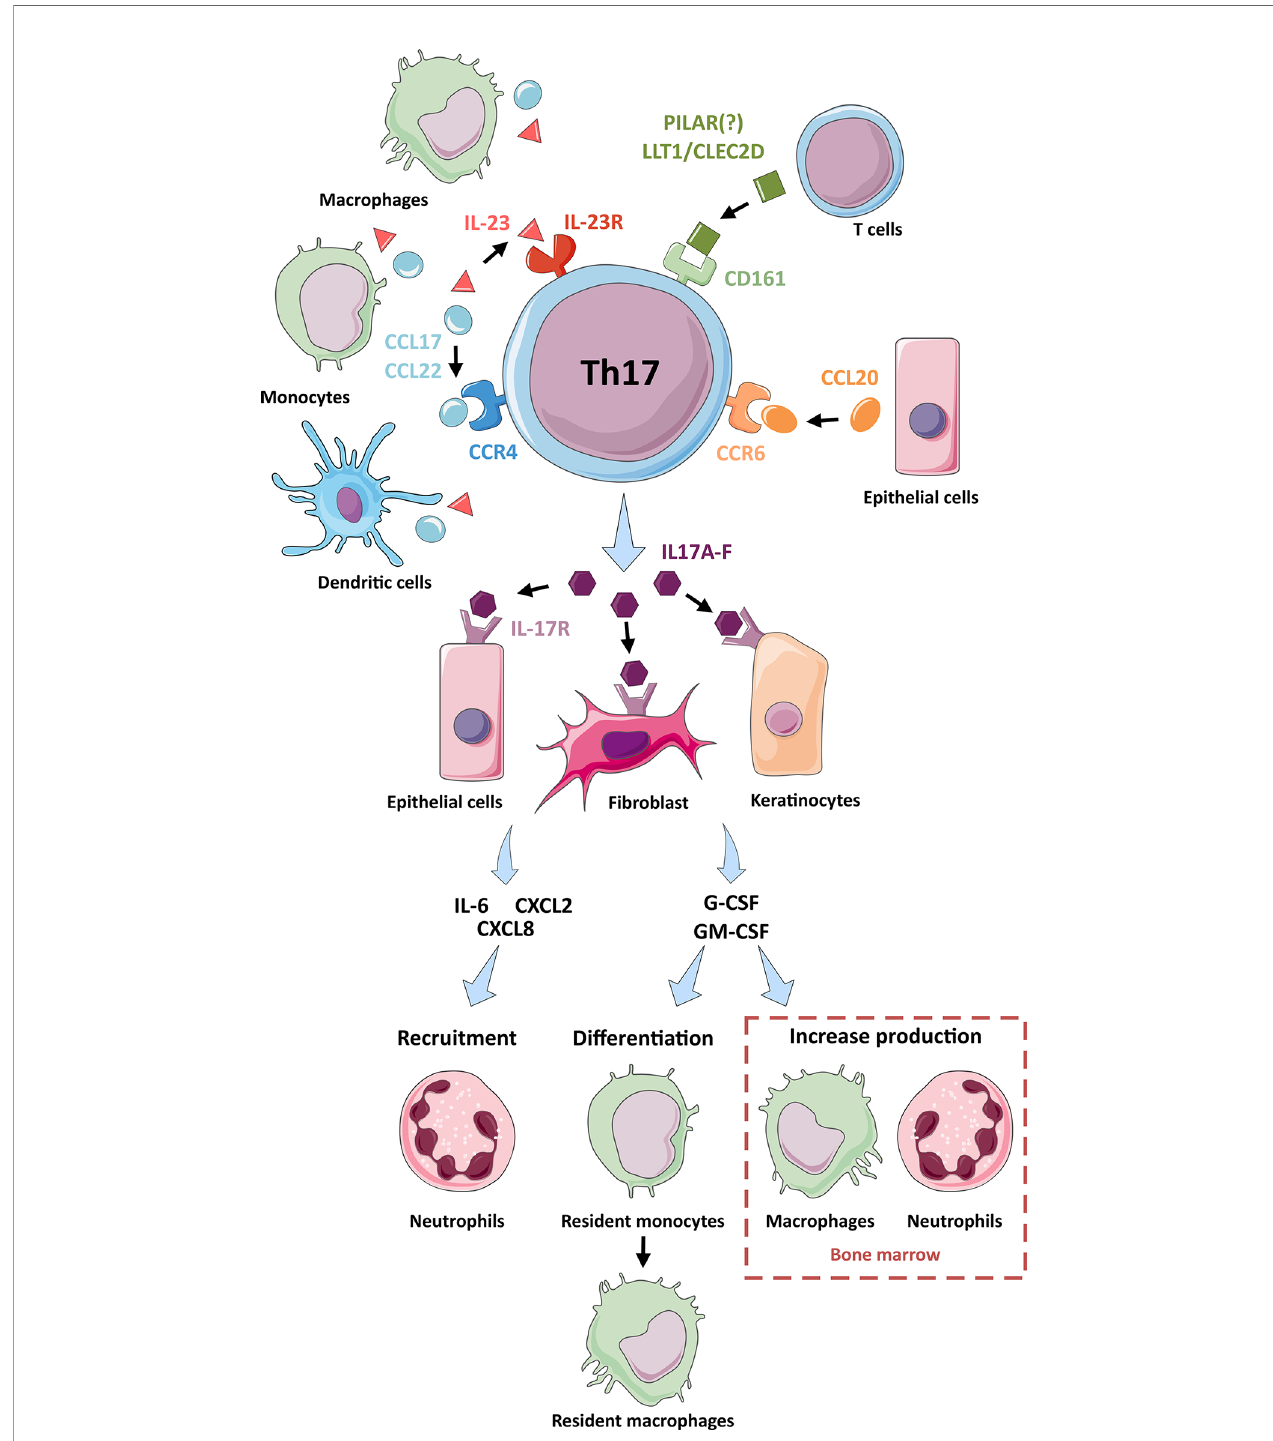
FIGURE 2 | Interactions and functions of Th17 cells. A representation of the interactions of Th17 cells with other cell types: Through their production ligands for receptors on the surface of Th17 cells (IL-23R, CD161, CCR4 and CCR6), macrophages, monocytes and dendritic cells (CCL17, CCL22 and IL-23 production), T cells (LLT1, CLEC2D and PILAR) and epithelial cells (CCL20) participate in the activation of Th17 cells and their production of IL-17 cytokines. The IL-17 cytokines produced by Th17 cells activate epithelial cells, fi broblasts, and keratinocytes via their IL-17R surface receptor. Following this activation, these cells produce chemotactic factors (IL-6, CXCL2 and CXCL8) which participate in the recruitment of neutrophils. These cells also produce G-CSF and GM-CSF, which are involved in the differentiation of resident monocytes into resident macrophages and the increased production of macrophages and neutrophils in the bone